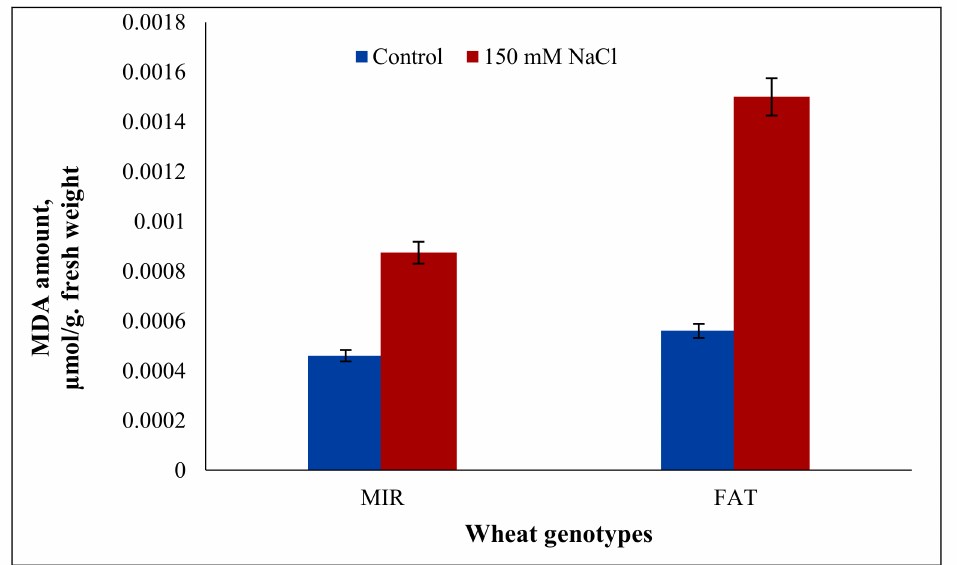
Figure 1. Effect of 150 mM NaCl on the MDA concentration in leaves of the salt-tolerant Mirbashir- 128 (MIR) and salt-sensitive Fatima (FAT) genotypes after 10 days of salt treatment. The values of standard error ( ± SE) in each bar were calculated for each treatment from three